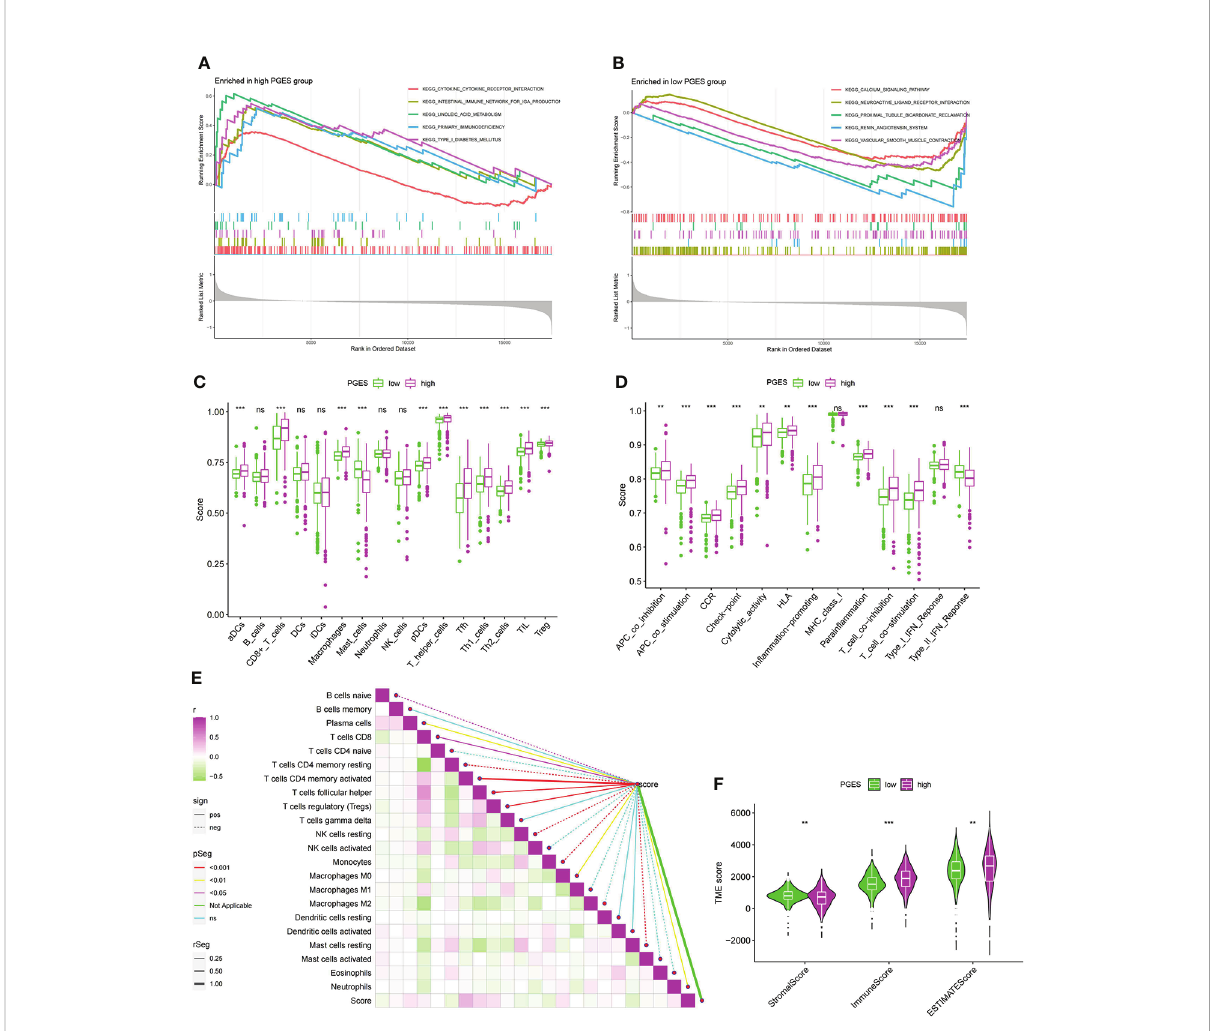
FIGURE 5 Functional enrichment analyses and immune in fi ltration characterization of different PGES groups. (A, B) Pathways enriched at high and low PGES. (C, D) Differences in immune cells and immune function among different PGES groups based on ssGSEA algorithm. (E) Correlation analysis between PGES and immune cells based on the CIBERSORT algorithm. (F) The stromal, immune, and estimate scores of the high- and low-PGES groups were evaluated by the estimate algorithm. PGES, polyamine gene expression score. **p < 0.01, ***p < 0.001 and ns means no signi fi